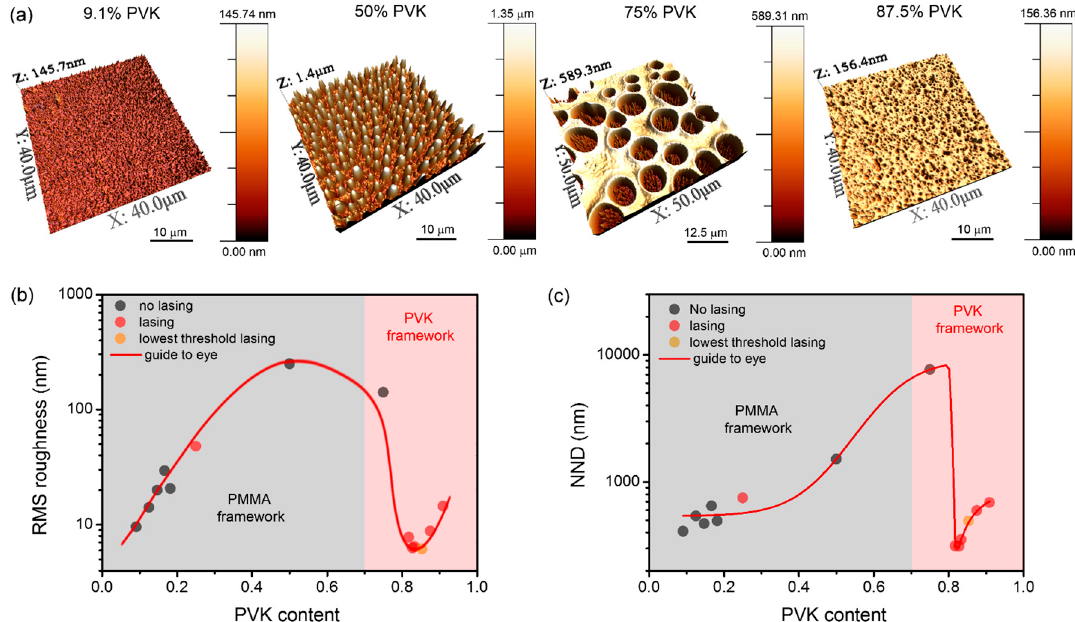
Figure 2. ( a ) A comparison of PMMA:PVK blend morphologies obtained in AFM measurements for different relative polymers concentrations, namely: 9.1, 50, 75, and 87.5% of PVK; ( b ) the dependency of roughness (calculated as RMS deviation from average height) on PVK concentration in PMMA:PVK blends; ( c ) the dependency of average nearest neighbor distance (NND) between hills or holes on PVK